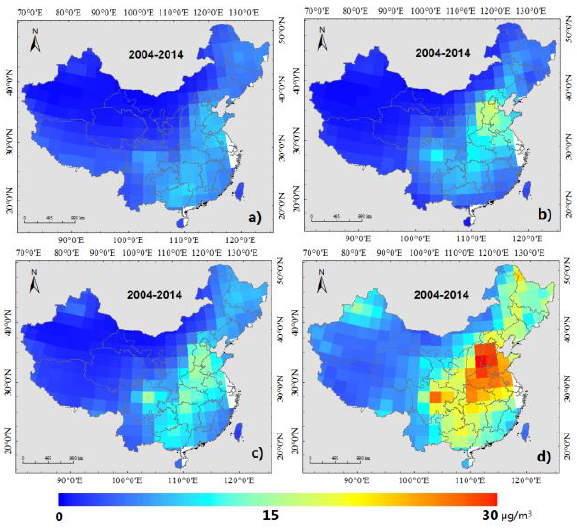
Figure 7. The same data shown in Figure 6 but for satellite- derived NH 4+ concentrations. ( a ) spring (March–May), ( b ) summer (June–August), ( c ) autumn (September–November) and ( d ) winter